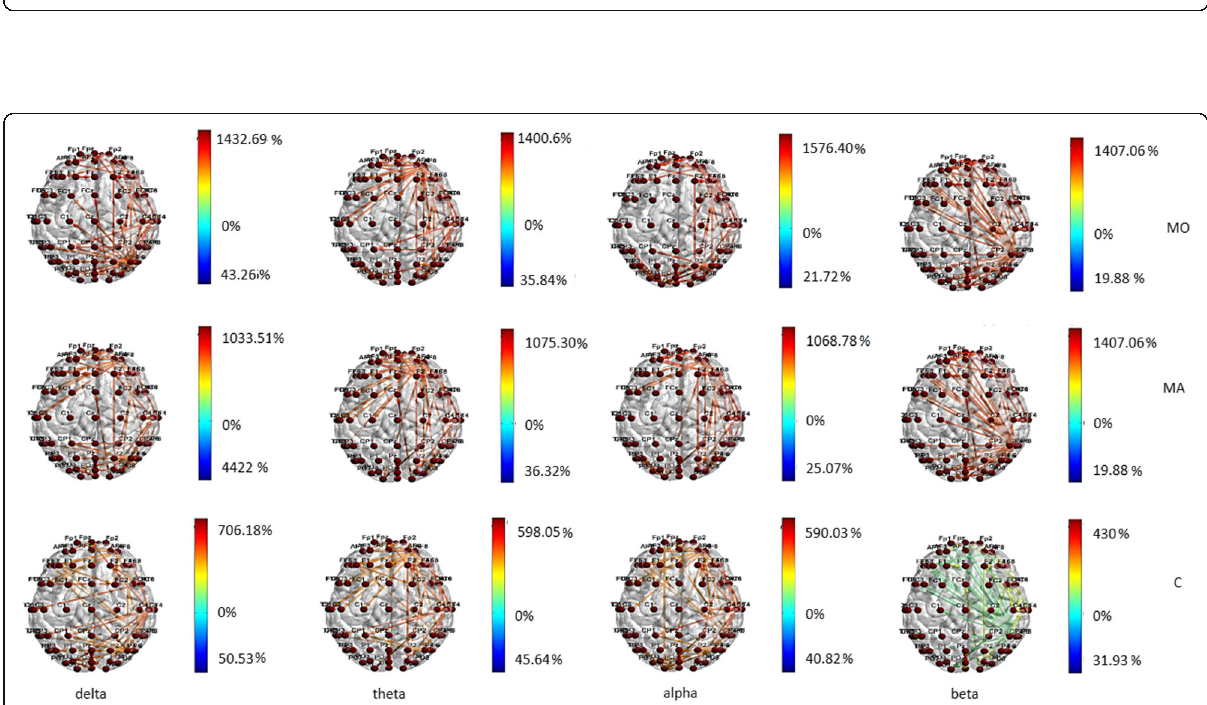
Fig. 4 Statistical differences in information transfer and their relative directions among nodes are depicted for the comparison of EEG bands under 2 cpd spatial frequency visual stimulation vs resting state condition in the Migraine with aura (MA), Migraine without aura (MO) and Controls (C) groups . Hot colors refer to a statistical prevalence of information transfer in the 0.5 cpd spatial frequency visual stimulation condition, cold colors for a prevalence in resting state. The color intensity is graduated on the relative percent difference. (further data on statistical analysis are available in the Additional file 1: section, chapter